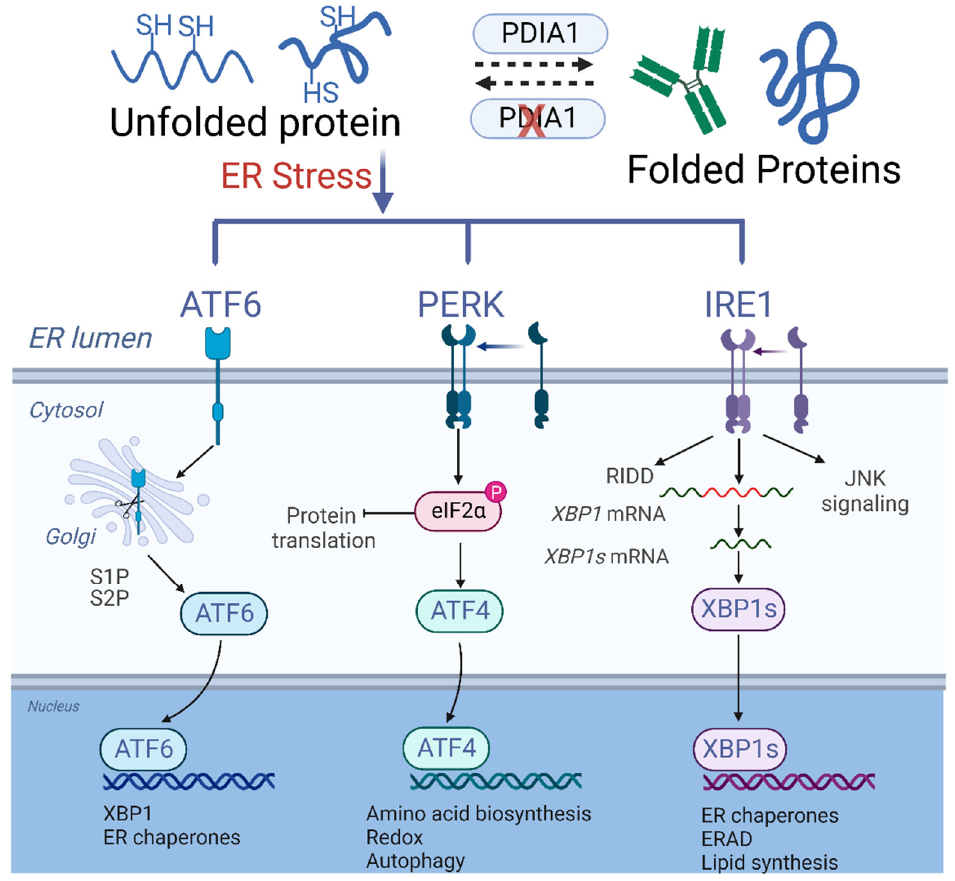
Figure 5. Heightened PDIA1 is critical to maintain ER homeostasis in MM Cells. Disruption of the ER causes dysregulation of the protein folding process, known as ER stress, secondary to the accumulation of unfolded or misfolded proteins. This leads to activation of the unfolded protein response (UPR), with subsequent activation of downstream pathways inducing apoptosis. Abbreviations: PDIA1, protein disulfide isomerase inhibitor A1; ER, endoplasmic reticulum; UPR, unfolded protein response.